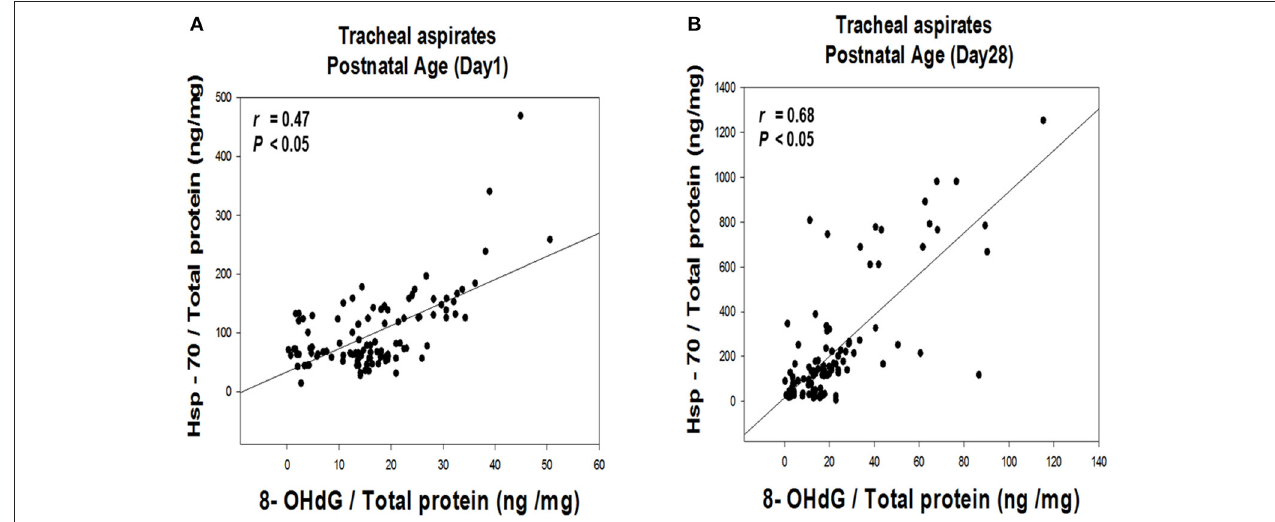
FIGURE 2 | Correlation between TA Hsp-70 and 8-OHdG levels on post-natal Day 1 (A) and Day 28 (B) of